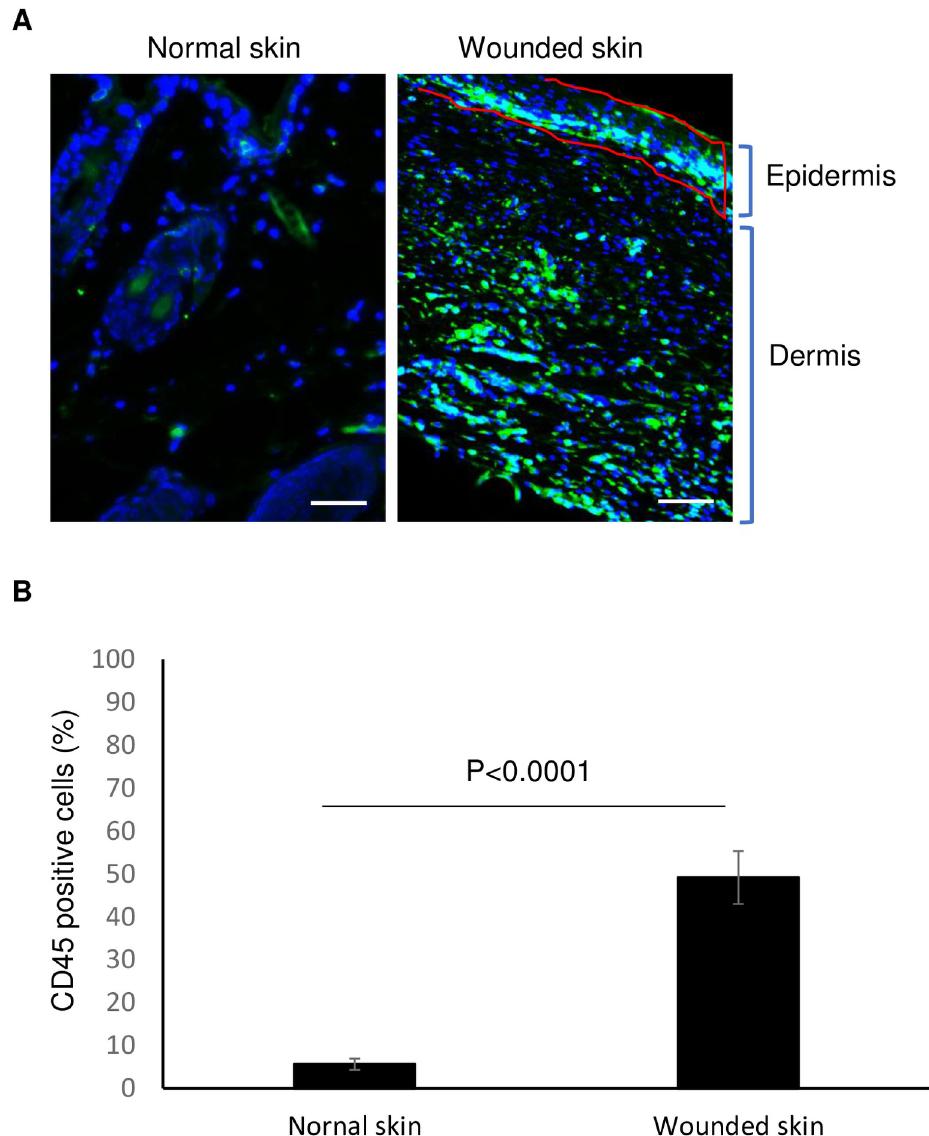
Fig 1. CD45-positive hematopoietic cells in skin wounds of mice. ( A ) Immunofluorescent staining in normal and wounded skin of mice with CD45 antibody. Balb/C mice with eight-millimeter punch biopsy excisional wounds for 14 days were euthanized and wounded skin and normal dorsal skin were harvested and fixed. Skin sections were prepared for immunofluorescent staining with CD45 antibody (green). DAPI (blue) was used as a nuclear counterstain. Scale bars in all images was 50 μ m. A representative of wounded skin of 16 wounds from 8 mice was shown. ( B ) The statistical analysis of CD45 positive cell percentage in skin sections is depicted. Ten HPF of five normal and five wounded skin were counted (n =